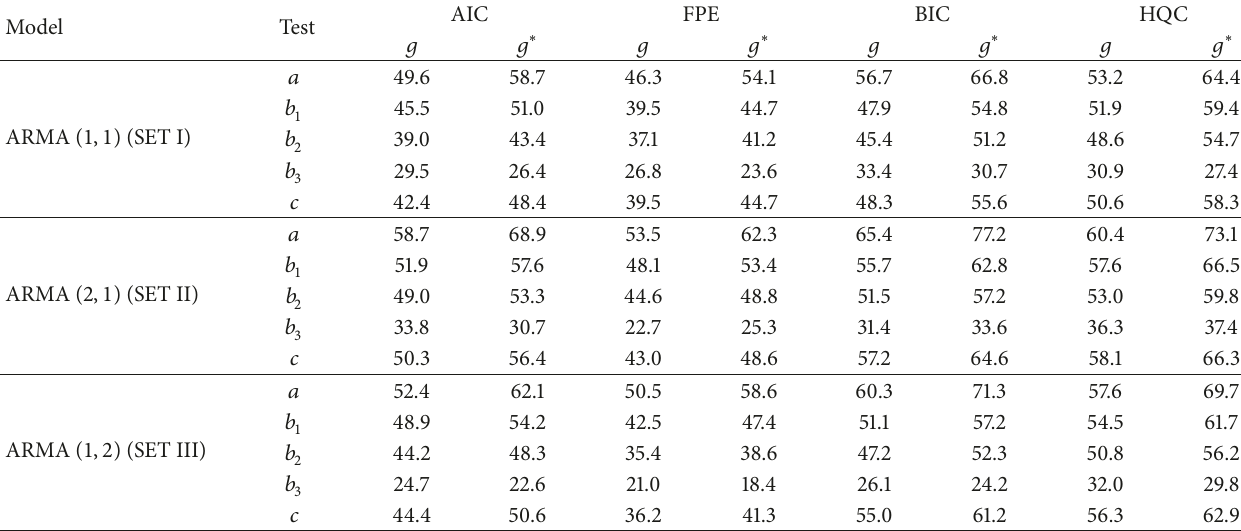
Table 3: Frequency of selection of the true model in the nonbootstrap ( 𝑔 ∗ ) and bootstrap ( 𝑔 ∗ ) world for 𝑇 = 200 . Model